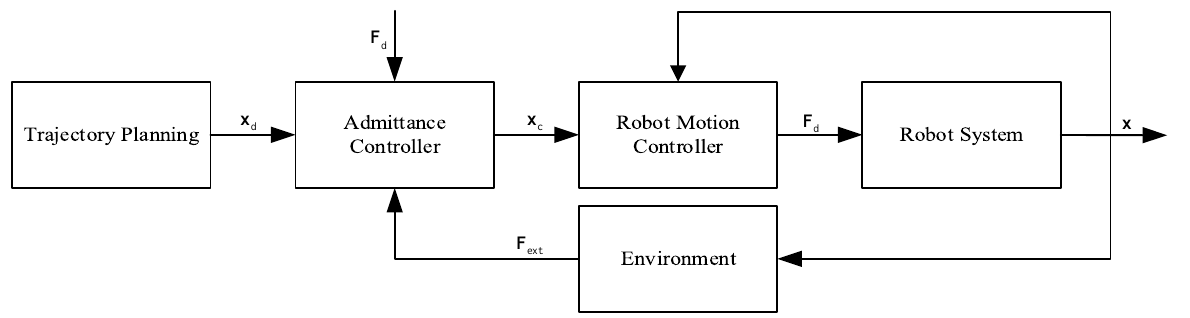
Figure 2. The realization of the admittance control. The definitions of symbols are the same as those in Figure